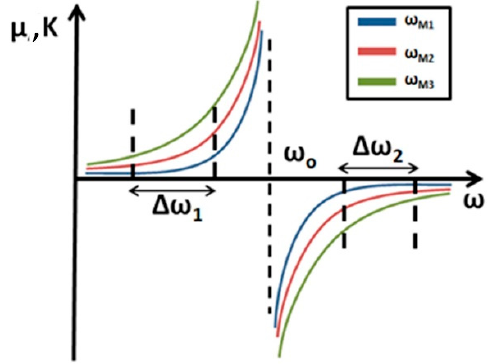
Figure 7. Schematic representation of two possible work zones for the presented EB device.